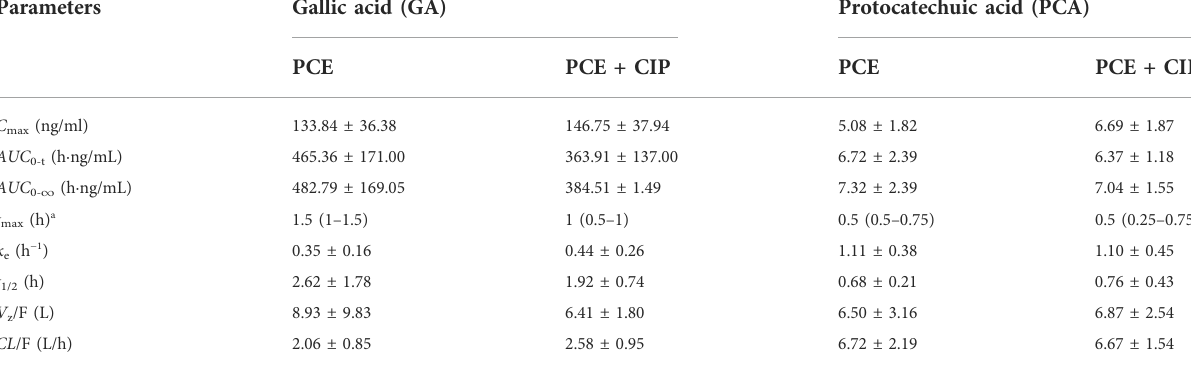
TABLE 4 Pharmacokinetic parameters of gallic acid and protocatechuic acid after intragastric administration of PCE (0.72 g/kg) with and without cipro fl oxacin (CIP, 0.045 g/kg) to rats (mean ± SD, n = 6). Parameters